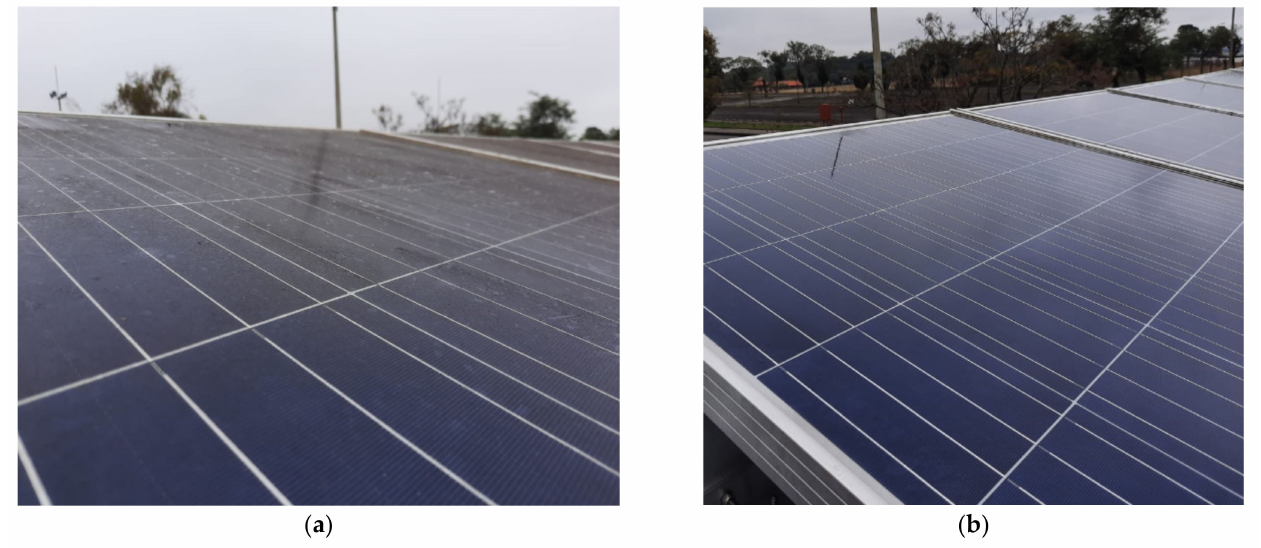
Figure 6. Comparison of the PV modules conditions: ( a ) before washing; ( b ) after